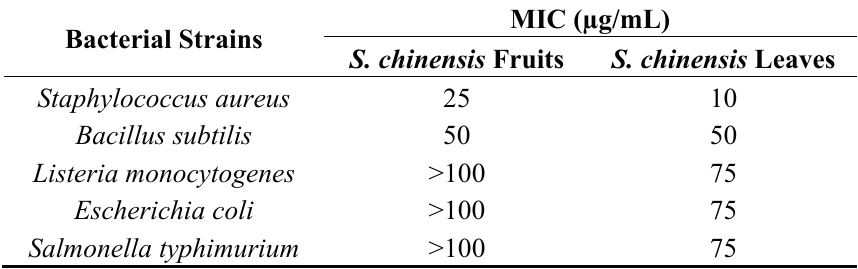
Table 6. Minimal Inhibitory Concentration (MIC) of S. chinensis extracts. Bacterial